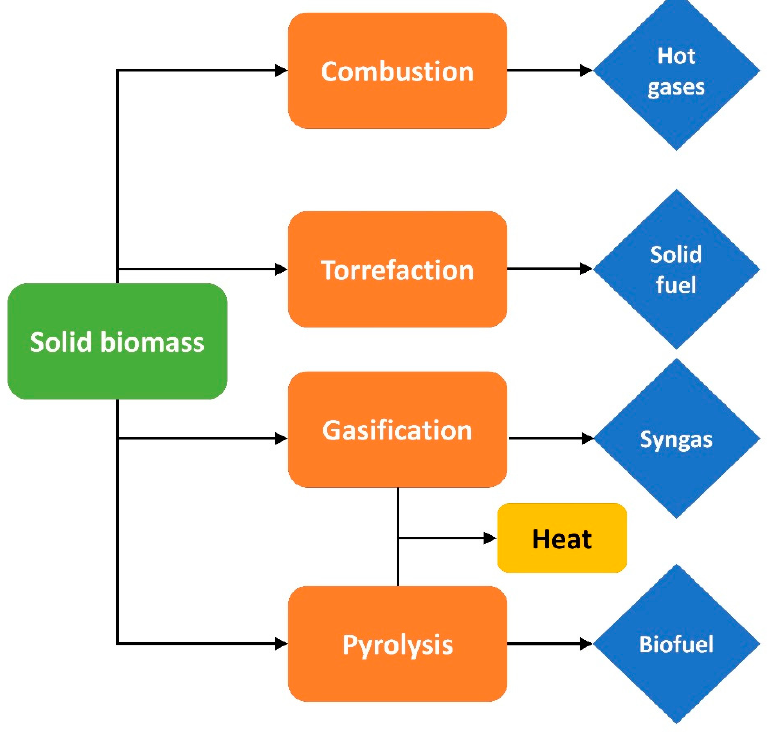
Figure 4. Main biomass thermochemical conversion technologies. Own design, based on information from [35,36,37].